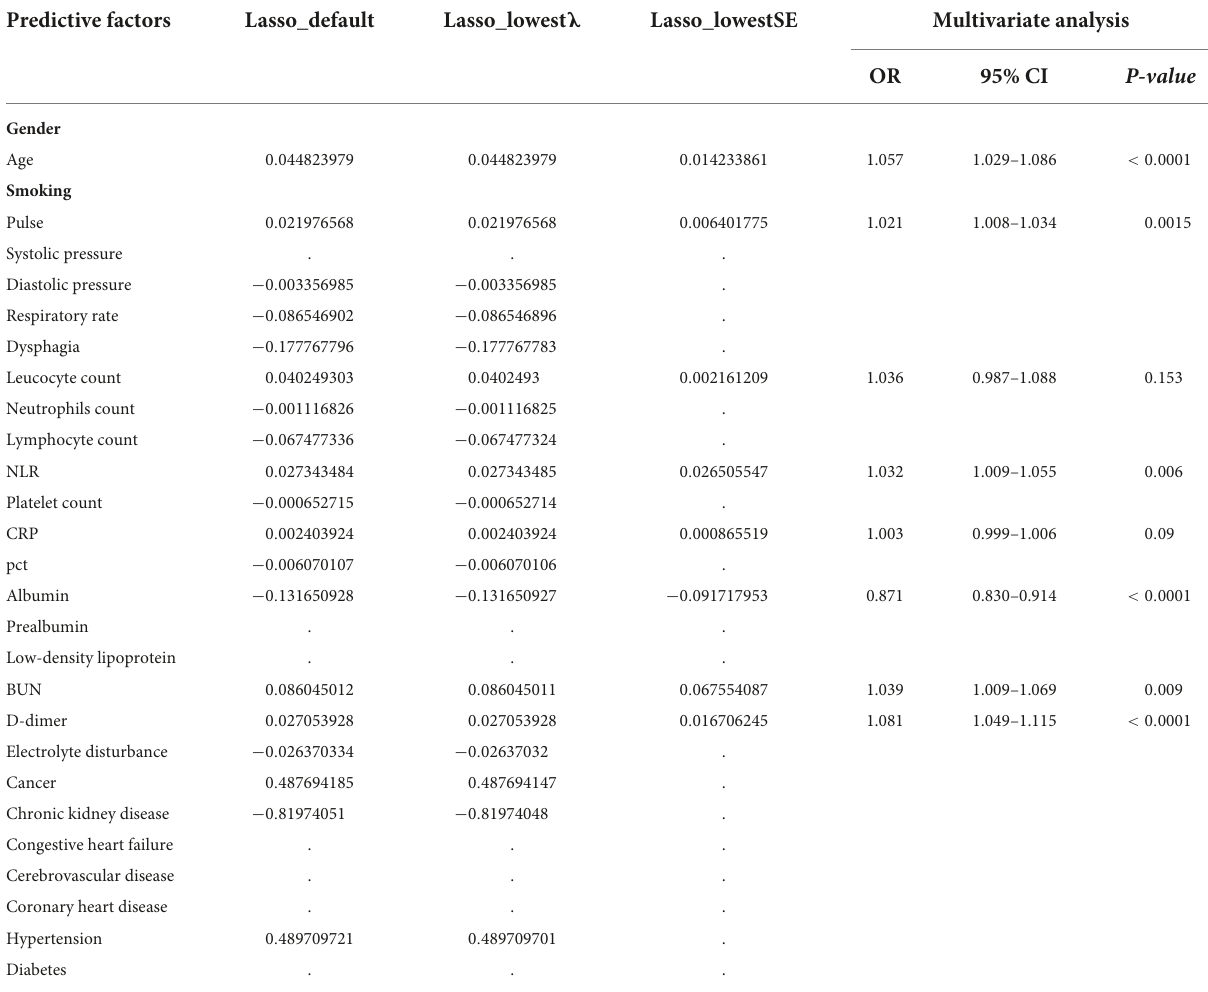
TABLE 3 LASSO analysis and multiple logistic regression